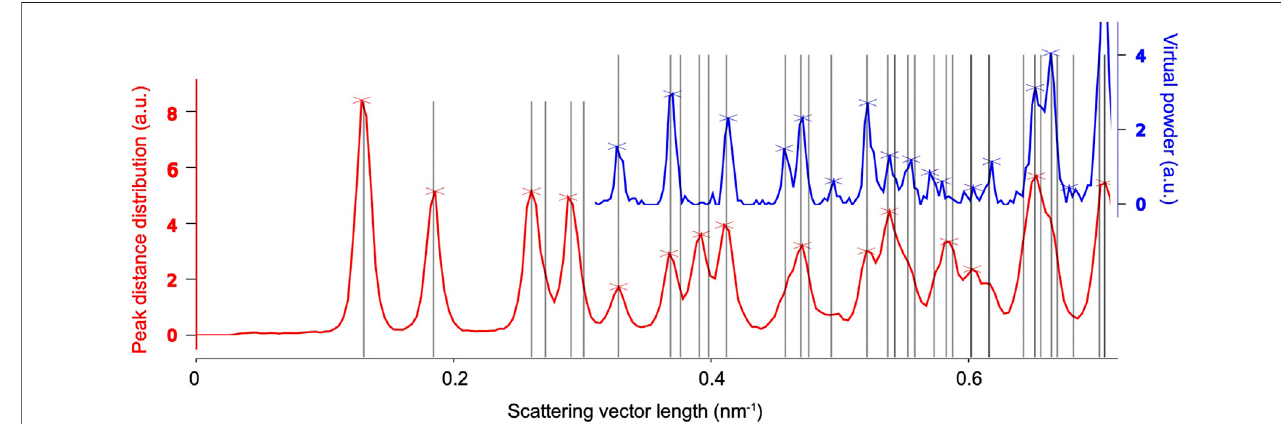
FIGURE 6 | Unit-cell re fi nement of the example system ’ s tetragonal cell with a (cid:2) 78 . 9 ˚ A , c (cid:2) 37 . 9 ˚ A. After peak fi nding, the scattering vector length, and the pair- wizedistancesbetweenthepeaks(withineachpattern)arehistogramizedoverallpatterns(blueandredcurves,respectively),yieldingpeaksattheinverselayerspacings of the crystal. The unit cell can accurately be re fi ned by fi tting the computed layer spacings (gray lines) to the observed peaks in both